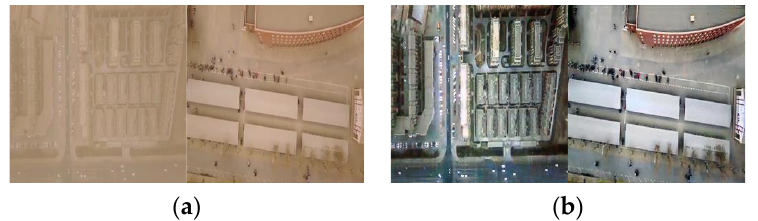
Figure 1. Results of the proposed method; ( a ) Aerial sand-dust images; ( b ) Results of the proposed algorithm.